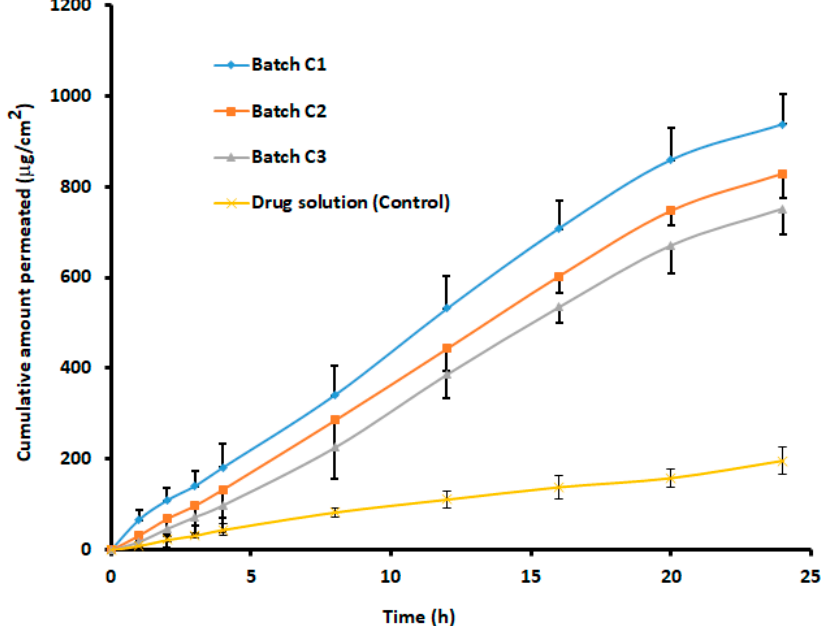
Figure 6. Comparison of rivastigmine permeation across isolated sheep mucosa from batches with different core-to-coat ratios. Batch C1 (nanoparticle: eudragit, 1:1), batch C2 (nanoparticle: eudragit, 1:3), and batch C3 (nanoparticle: eudragit, 1:5). The data represent an average ± SD of six trials.